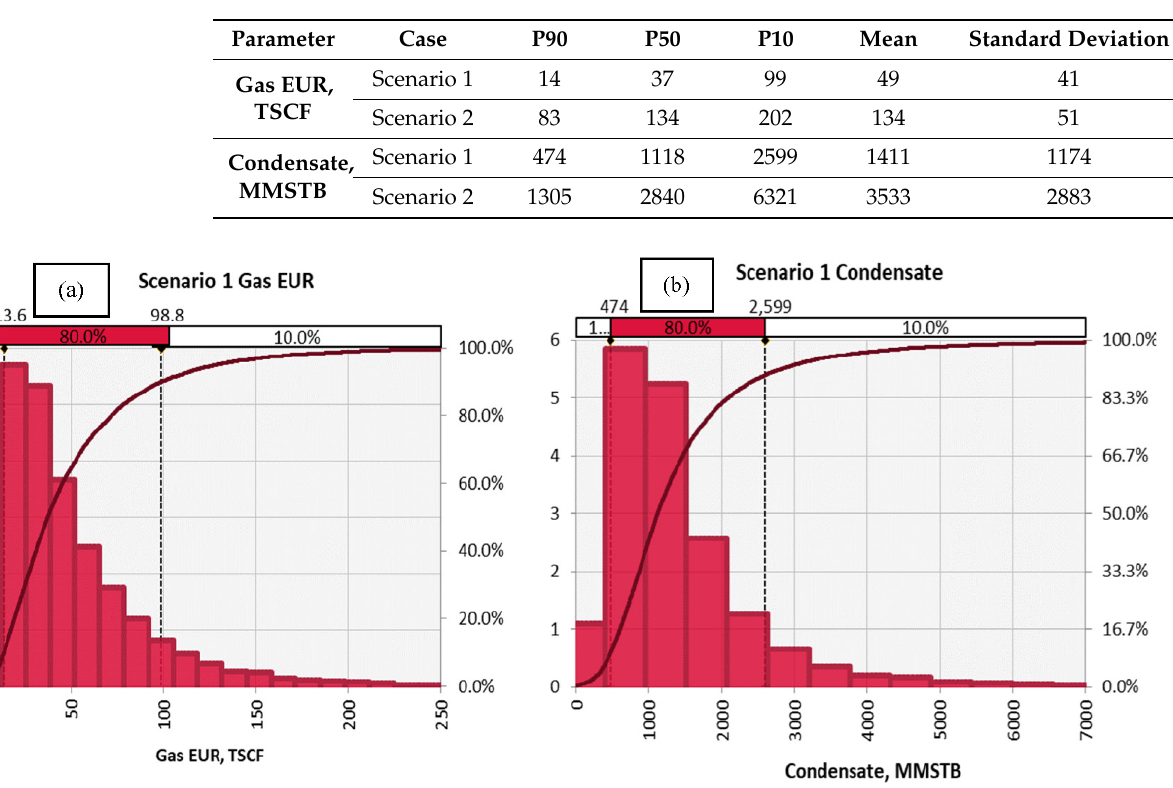
Figure 13. Scenario 1. Estimated ultimate recovery (EUR) of ( a ) gas EUR and ( b ) condensate.